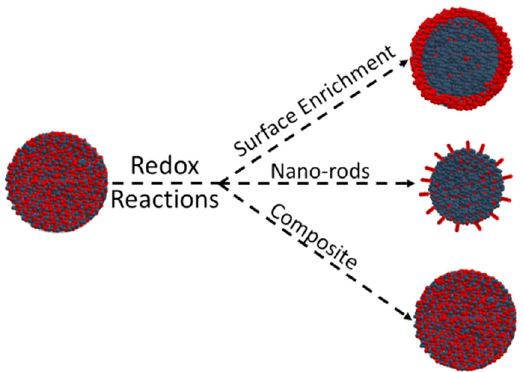
Figure 14. Ionic di ff usion-induced structural changes in oxygen carrier particles, reprinted from [34], with permission from Elsevier.